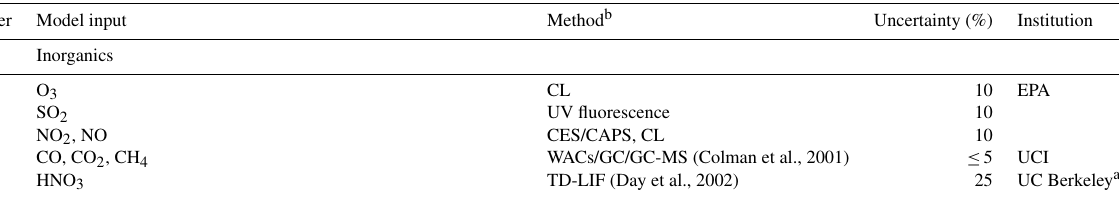
Table 1. Measured parameters input into RACM2 and MCMv331. Inorganic chemical species measurement time resolution is 1min. Aircraft chemical species were measured every 1s. Evacuated whole-air canister VOC point measurements were interpolated to 1h medians as described in Sect. 2.2. All measured constraints were either averaged or interpolated to 10min for model